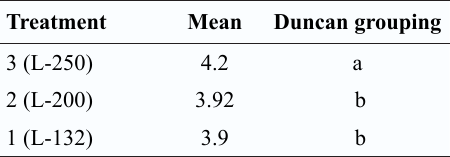
Table 3. Shoot height (cm) comparison of thorny artichoke ( Cynara scolymus L.) of three clonal lines in the rooting stage.